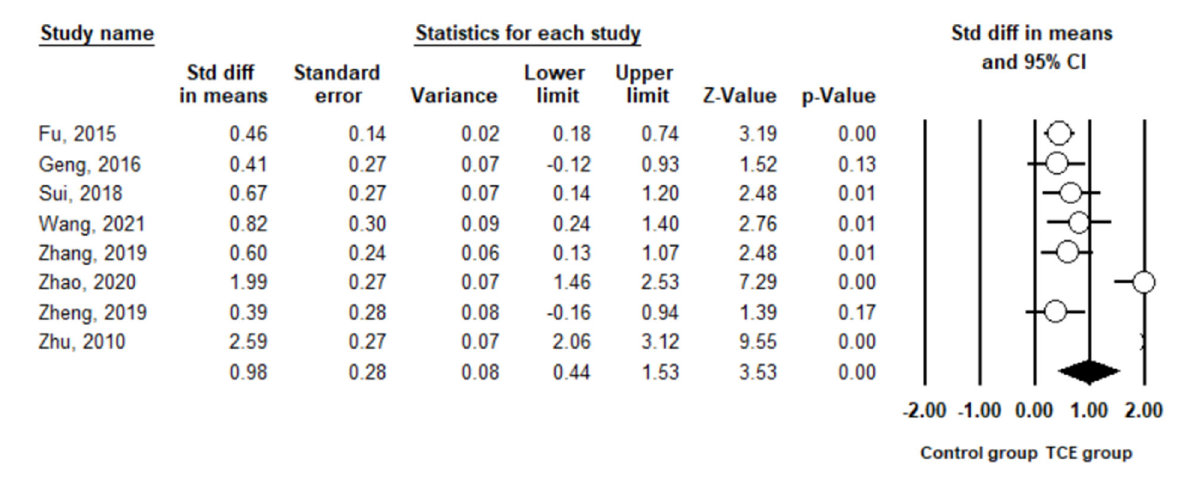
random-effects model (Figure